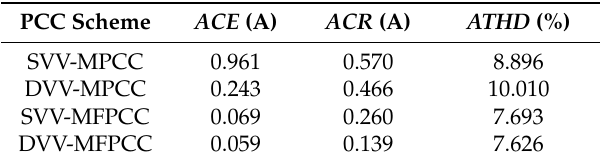
Table 9. ACE , ACR , and ATHD of the four schemes obtained from Figures 20–23.